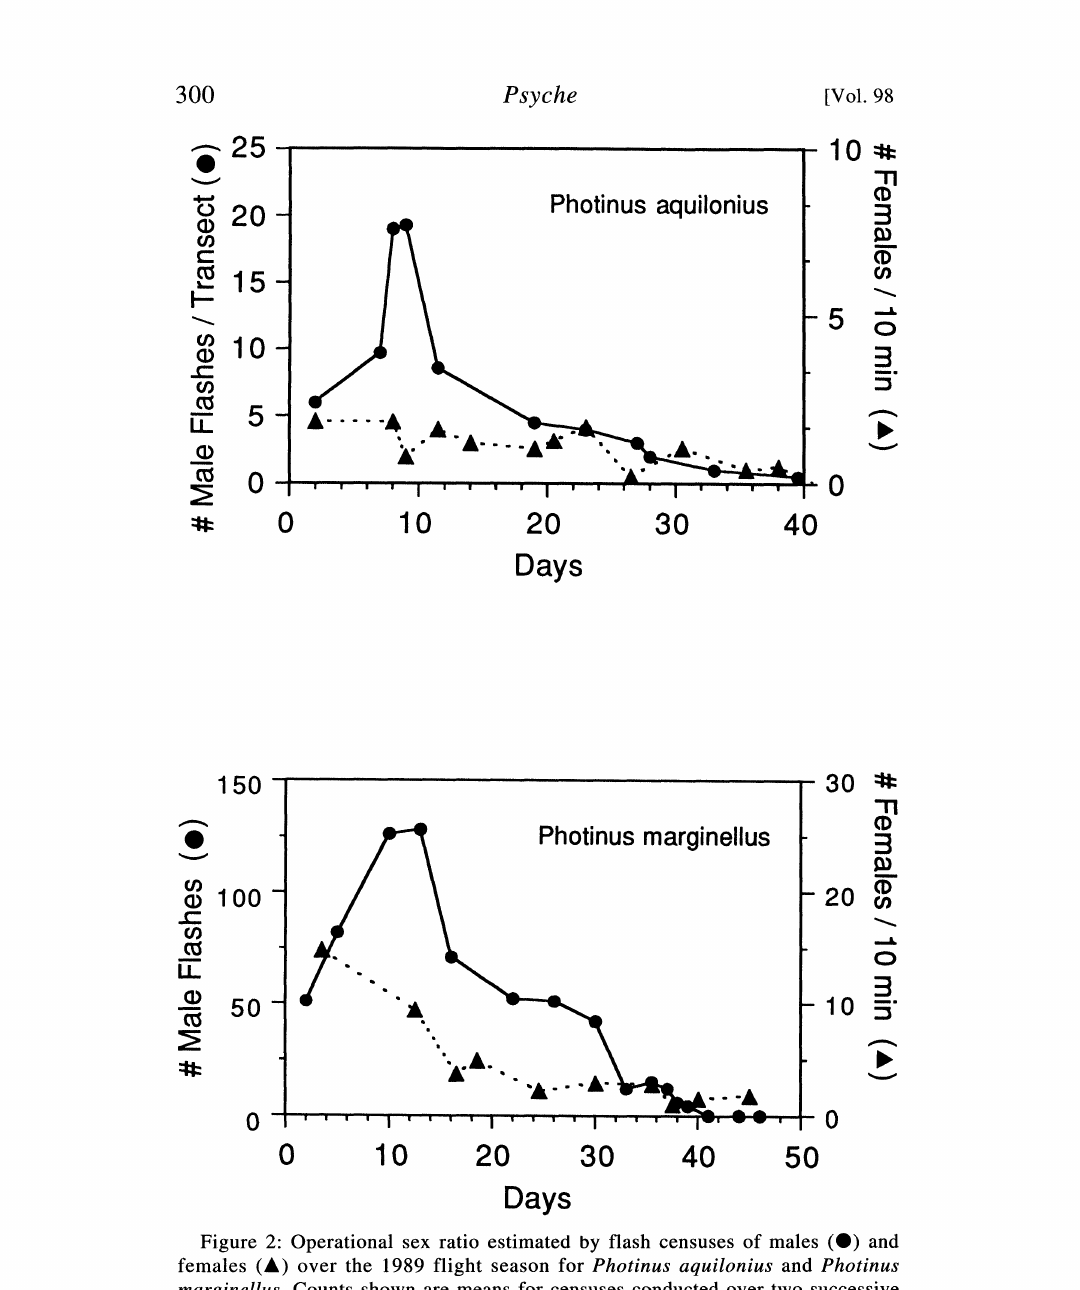
Figure 2: Operational sex ratio estimated by flash censuses of males (O) and females (&) over the 1989 flight season for Photinus aquilonius and Photinus marginellus. Counts shown are means for censuses conducted over two successive